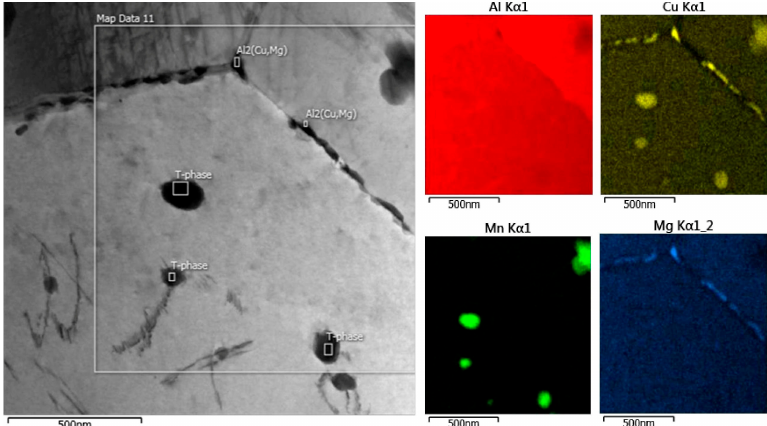
Figure 10. EDS maps of specimen W-0RS-160.